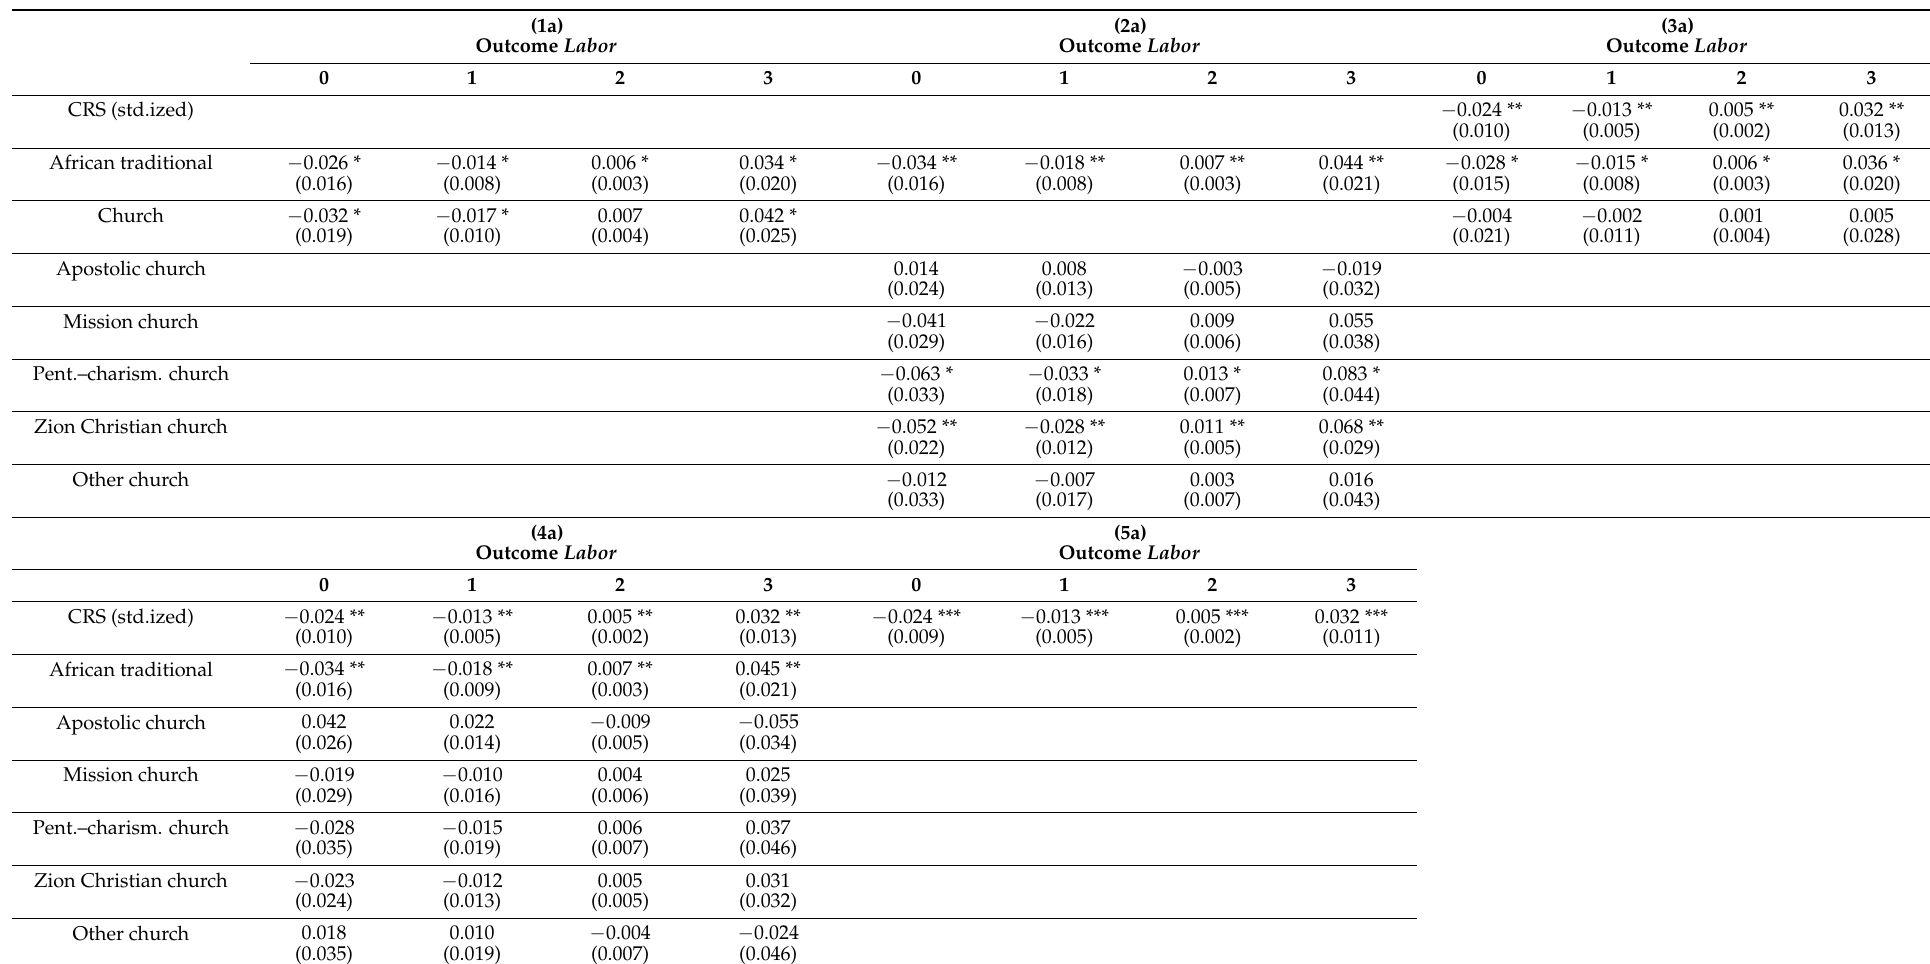
Table 8. Average marginal effect estimates for Table